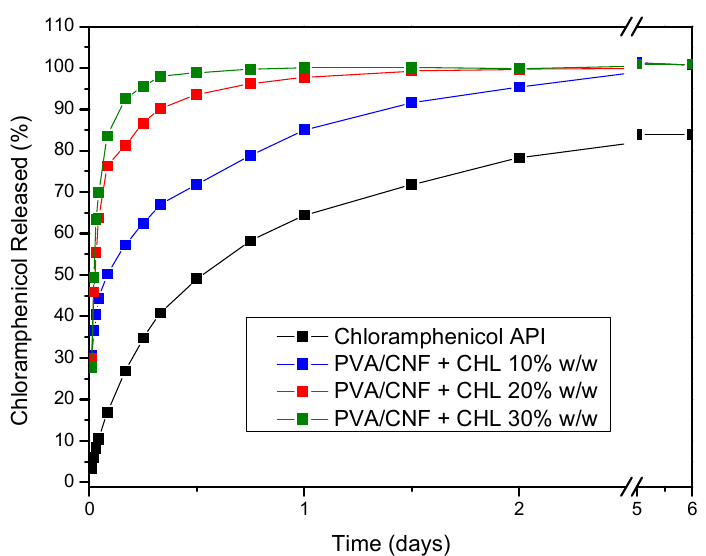
Figure 10. Release profile of poly(vinyl alcohol) (PVA)/cellulose nanofibril (CNF) sponges with 10% w / w CNF, containing chloramphenicol in 10, 20, and 30% w / w concentrations, compared to pure CHL.